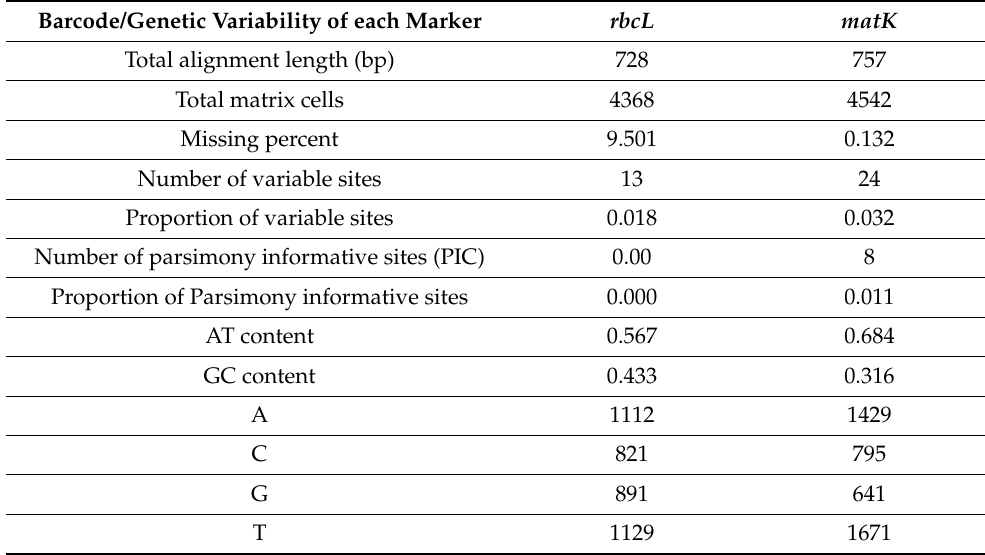
Table 8. Genetic variation estimates of DNA barcoding of 2 chloroplast ( matK and rbcL) genes of 16 T. aestivum genotypes.